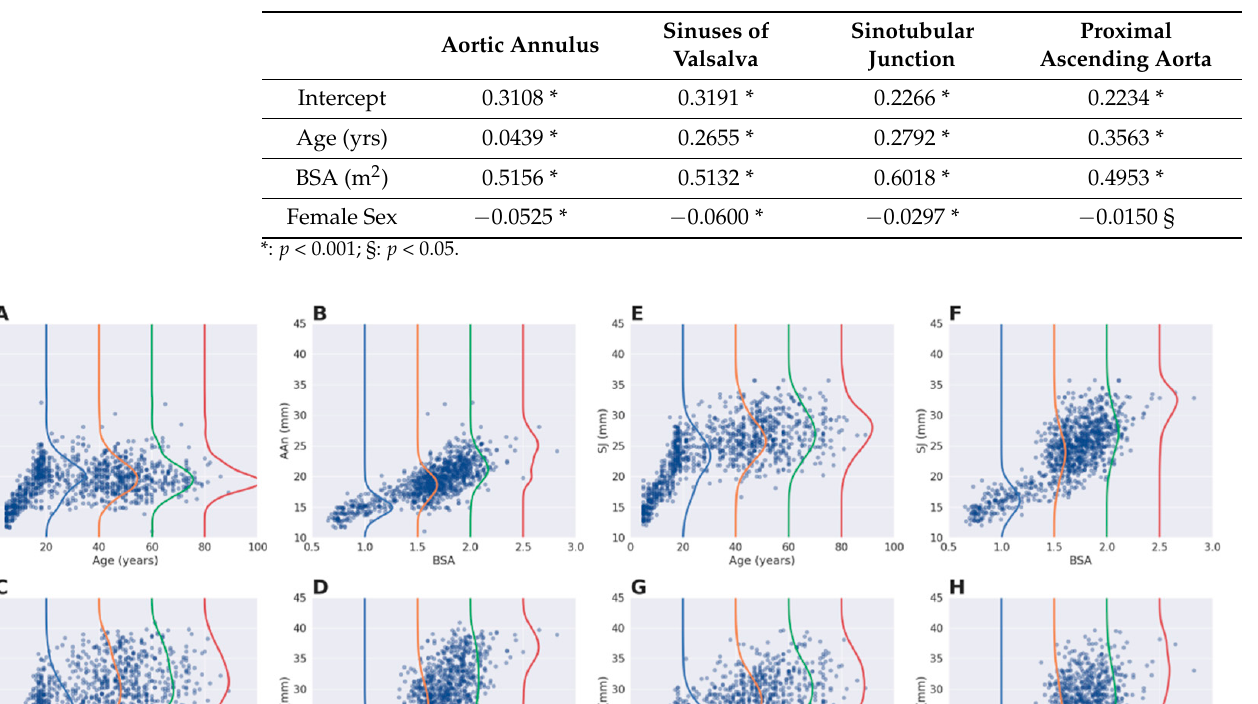
Table 3. Association of age, BSA, and sex with the aortic diameter at the 4 investigated levels. Age and BSA were normalized before linear regression (Age max = 89, BSA max = 2.821).